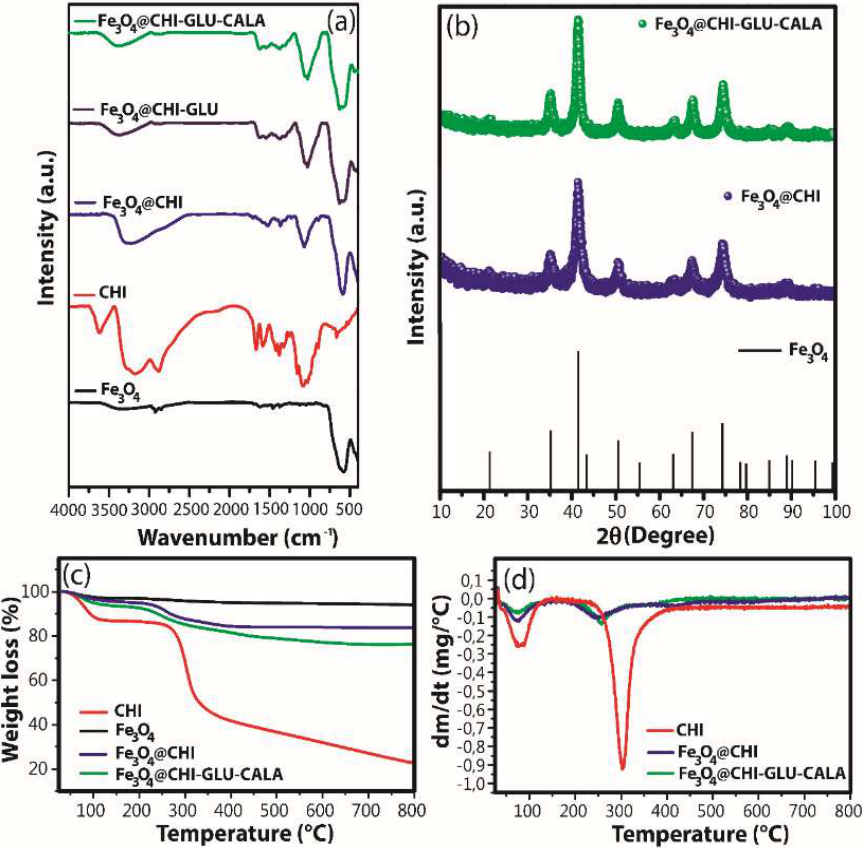
Figure 2. ( a ) FTIR, ( b ) XRPD, ( c – d ) TG and DTG of the synthesized samples.